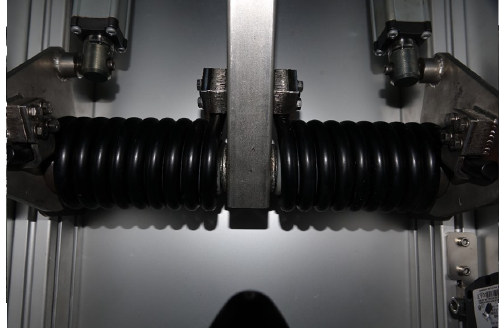
Figure 5. Ball Training Machine—spring